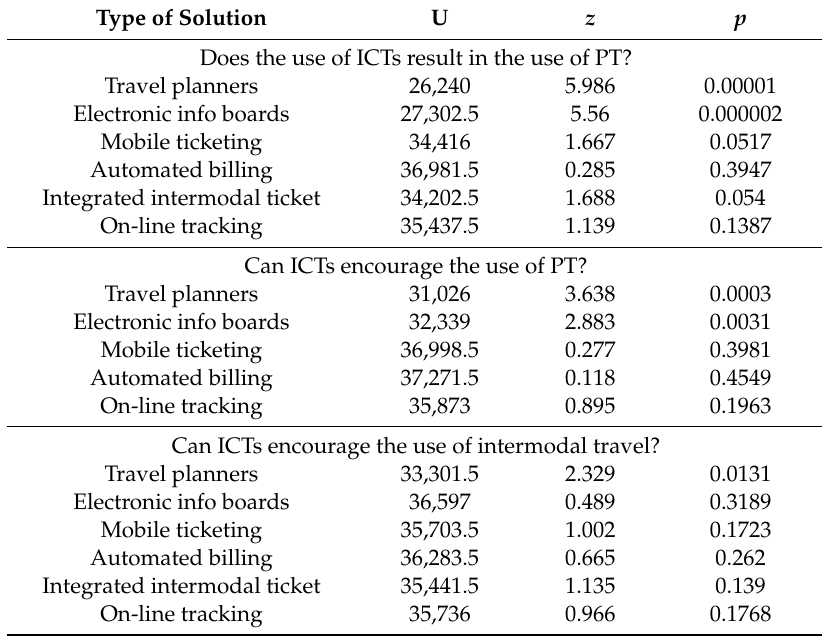
Table 5. Mann–Whitney U-tests results comparing car owners and non-car